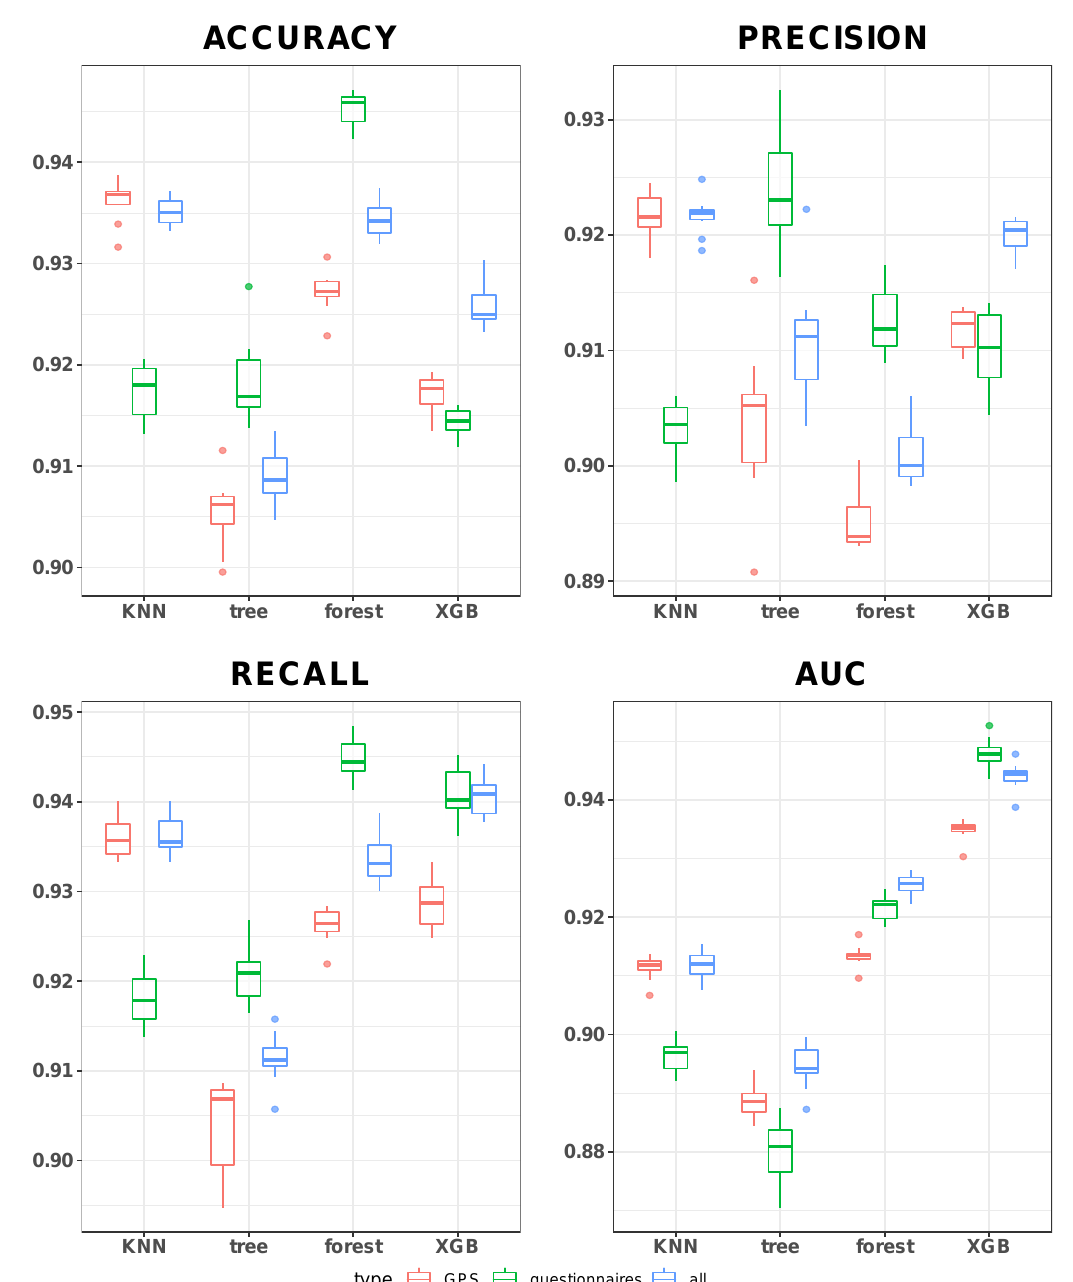
Figure 5. One-week predictive performance of best models according to three types (in color) of data sets. Predictive results are presented as box plots, in which the box indicates quartile values; the whiskers indicate the upper and lower values; circle indicates